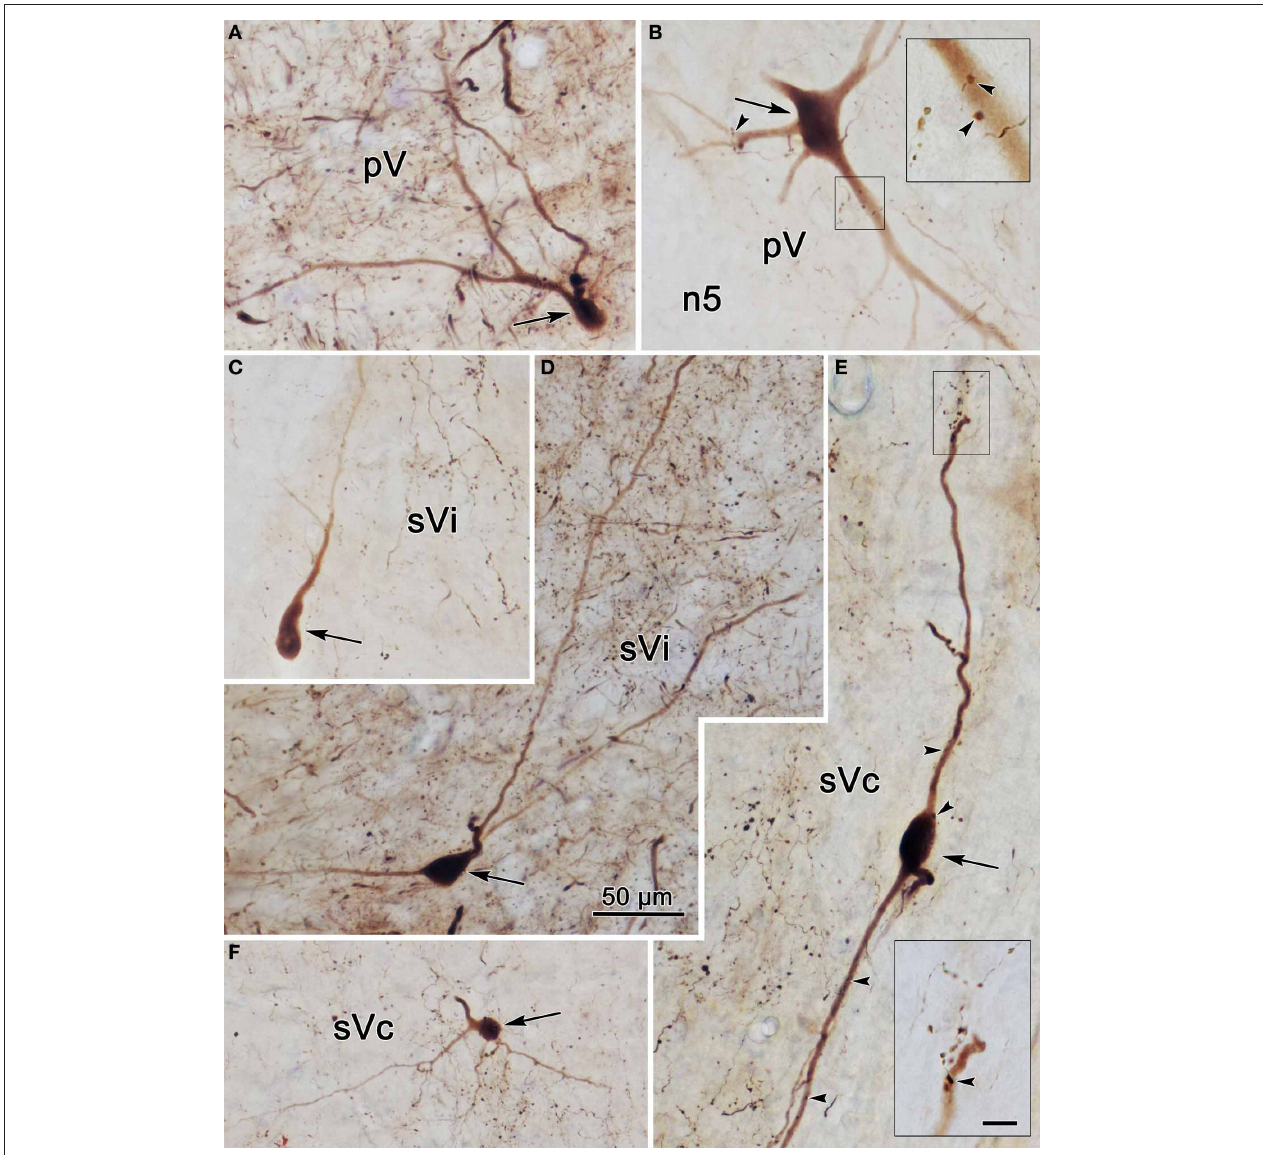
FIGURE 10 | Photomicrographs of labeled neurons (arrows) and axons within the trigeminal subnuclei following a unilateral injection into sVc (Figure 7B). Panels (A,D) are from the ipsilateral side, while panels (B,C,E,F) are from the contralateral side. The box shows the presence of close associations (arrowheads) between